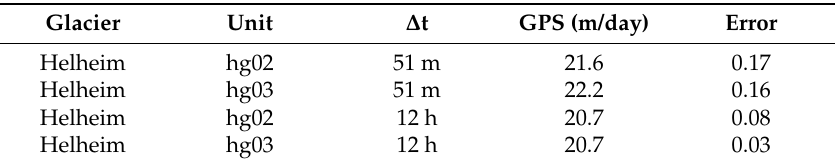
Table 3. GPS results for Helheim